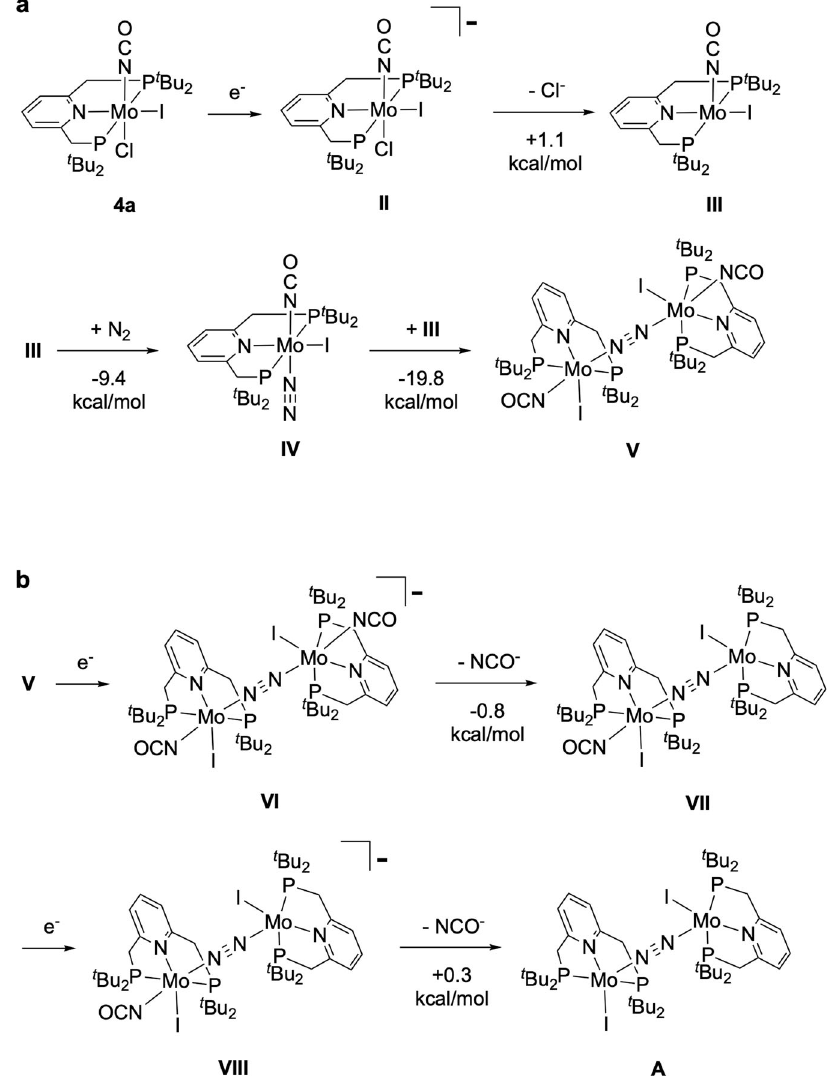
Fig. 6 | A possible reaction pathway for the conversion of isocyanate complex 4a to dimolybdenum complex A. a Free energy pro fi les at 298K ( Δ G 298 )